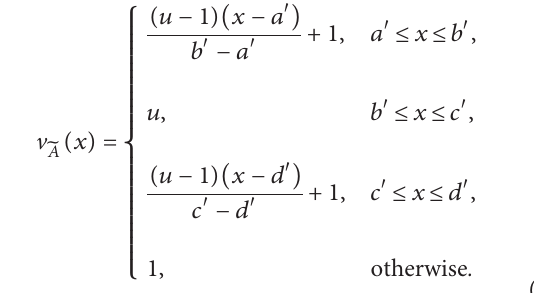
Figure 1: An IFN 􏽥 A � ( μ 􏽥 A , v 􏽥 A )